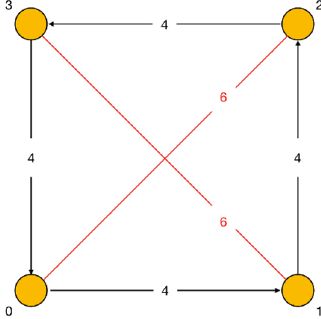
Figure 6. Quiver diagram for C 4 = Z 4 .